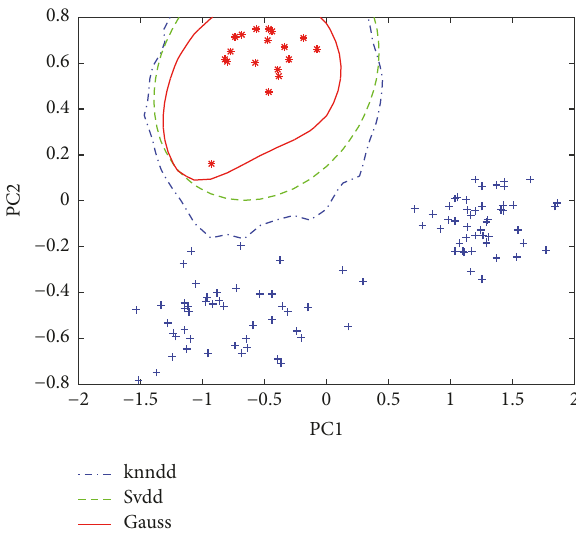
Figure 2: Data description boundary of class A on the first two- principal-component space based on the training set.